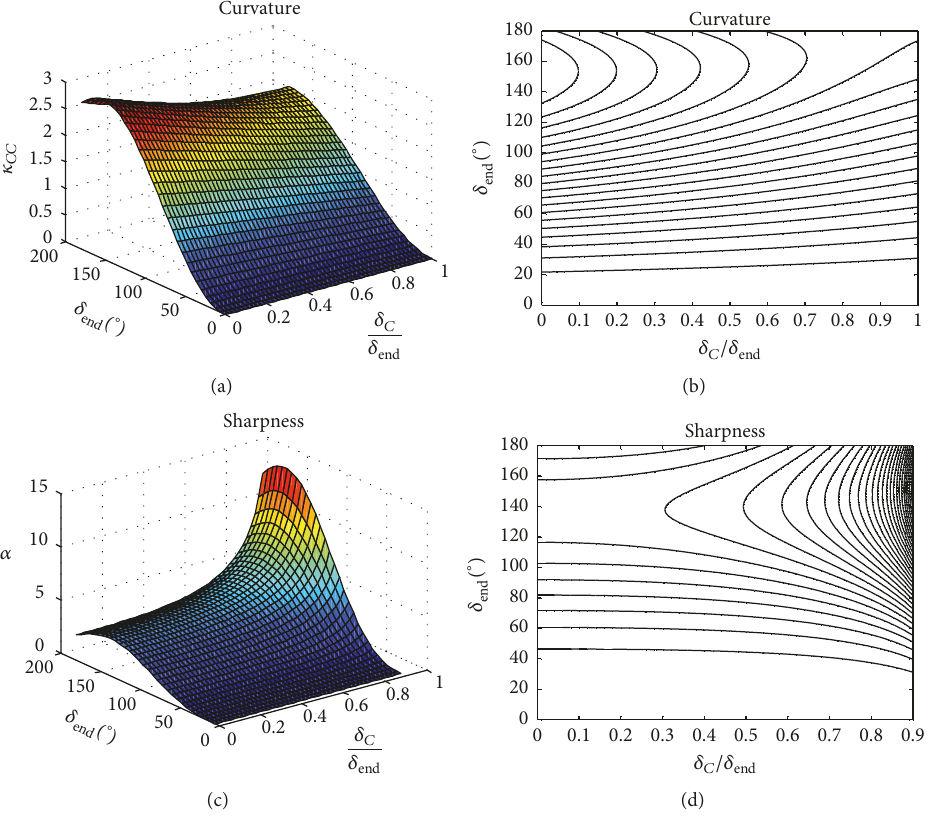
Figure 8: Dependence of (a)-(b) maximal curvature and (c)-(d) sharpness of CC-turns on the full detection and relative amount of the circular part (absolute values are